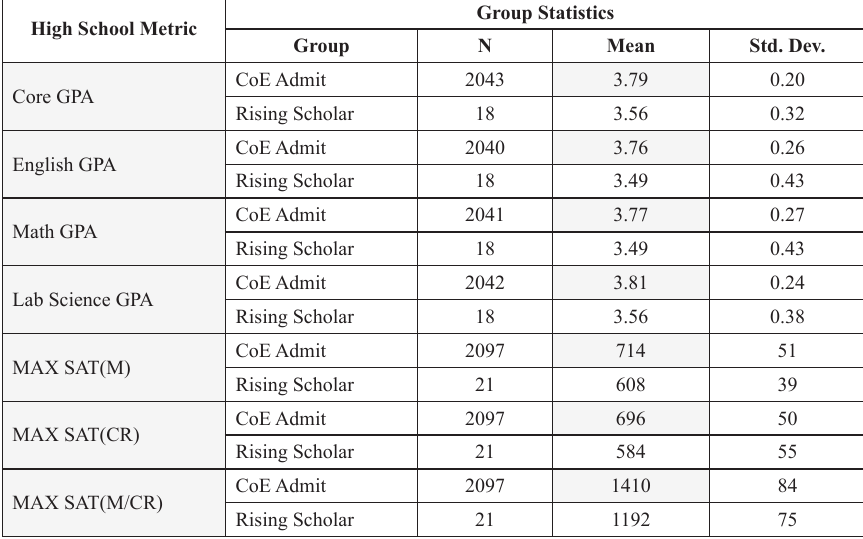
Table 8. Group statistics of High School Incoming Metrics compared between Purdue College of Engineering Direct-Admit students against Rising Scholar students